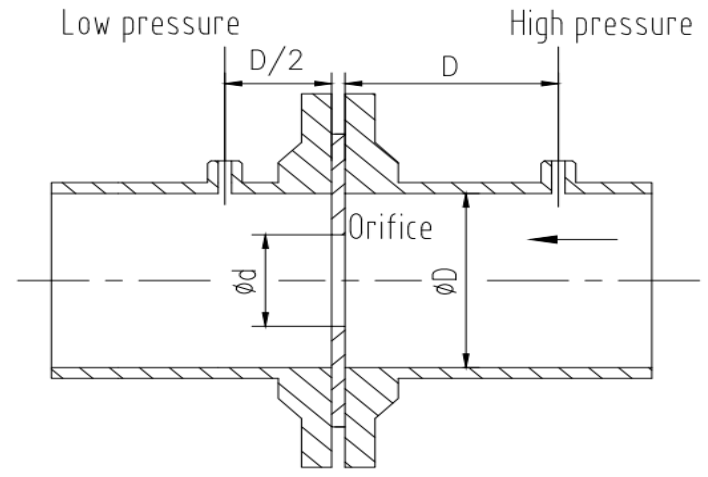
Figure 3. Illustration of the orifice flowmeter.